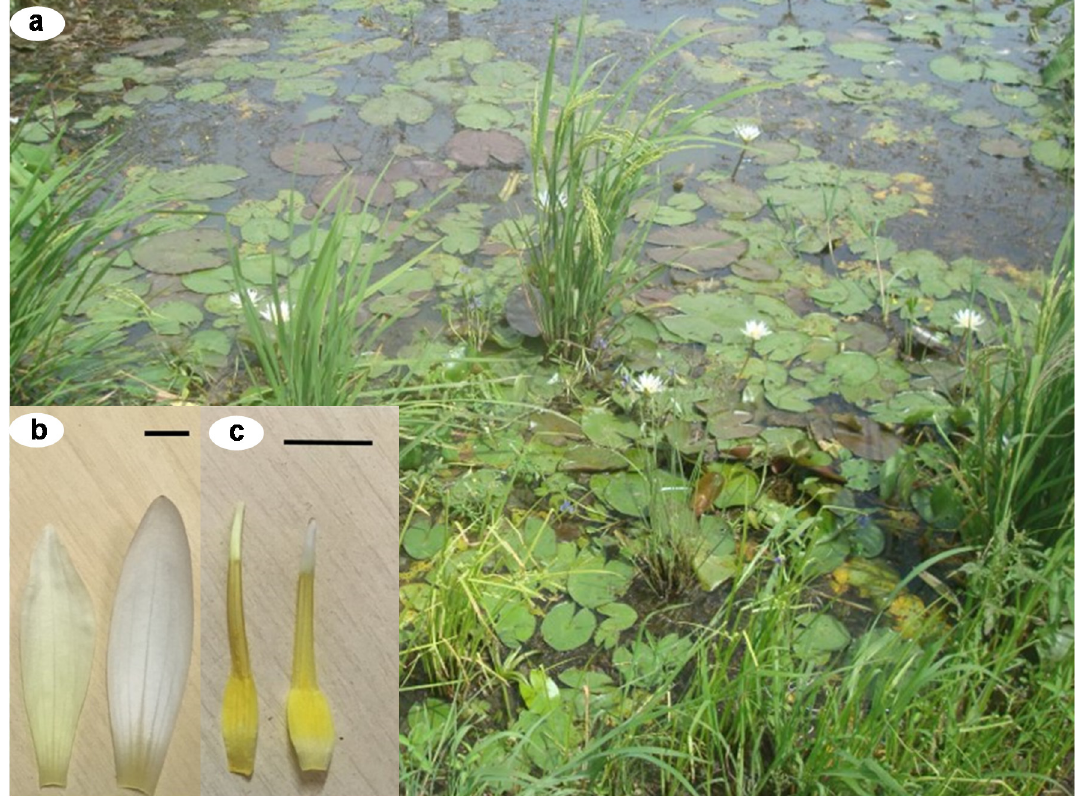
Figure 1. Pictures of Nymphaea lotus plants used in the present study. ( a ) N. lotus in its natural habitat in Nakhon Sawan province, Northern Floristic Regions of Thailand; ( b ) N. lotus petals (Bar scale = 1 cm); ( c ) N. lotus stamens (Bar scale = 1 cm). Pictures by Duangjai Tungmunnithum.